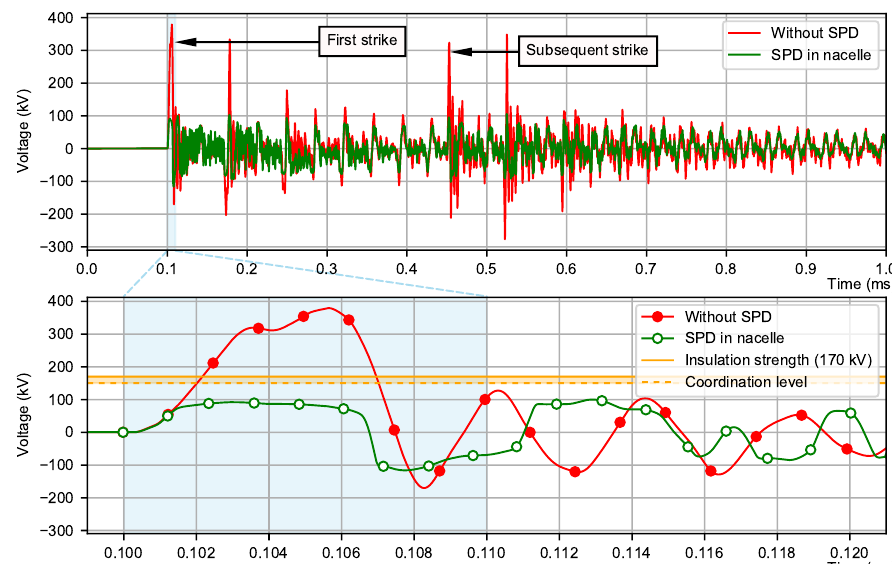
Figure 4. Transformer overvoltage(s) with and without surge arrester (SPD) with 60 kA and 4/75 µ s (first stroke), and 20 kA and 1/75 µ s (subsequent stroke).